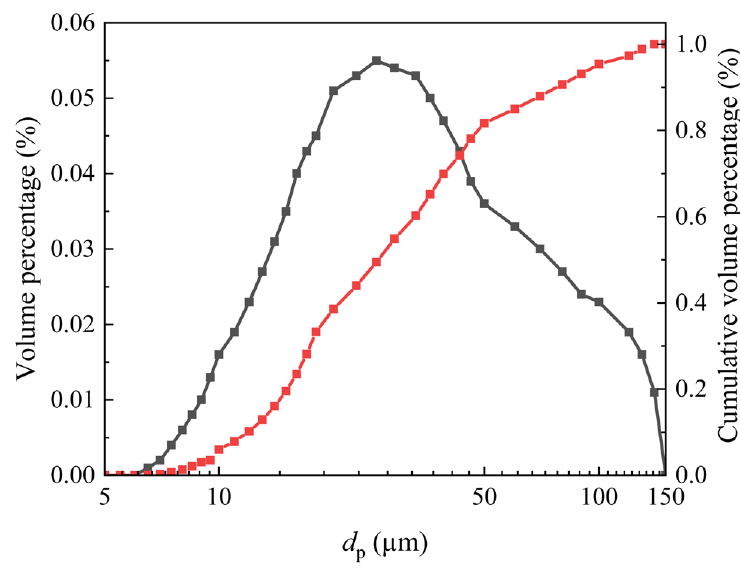
Figure 5. Particle size distribution in